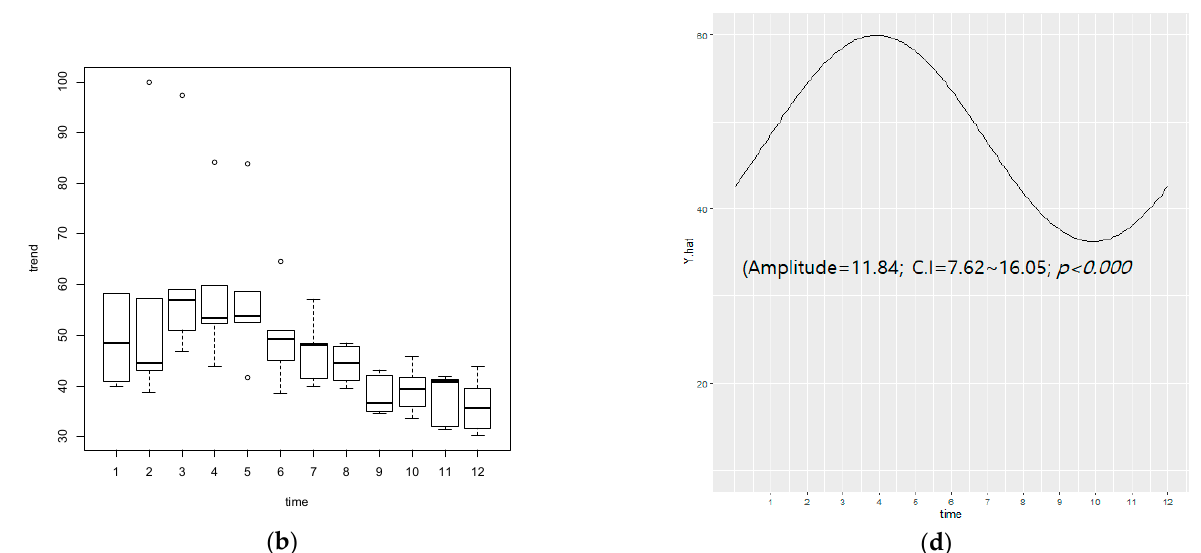
Figure 3. Monthly search volume and cycle for diet in South Korea. Search volume of ( a ) Google Trends and ( b ) Naver data. Cycle by cosinor analysis of ( c ) Google Trends and ( d ) Naver data. CI: 95% confidence interval; unit of time is 1 month.; p -value < 0.05 corresponds to the statistical significance of seasonal periodicity of diet interest in each group.